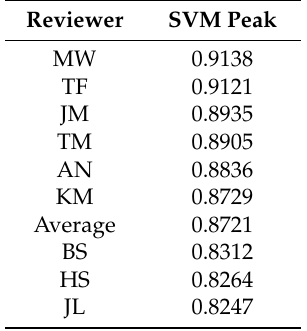
Figure 9. Evaluation results for each wine reviewer based on SVM. Table 8. Reviewers by order of SVM accuracy.